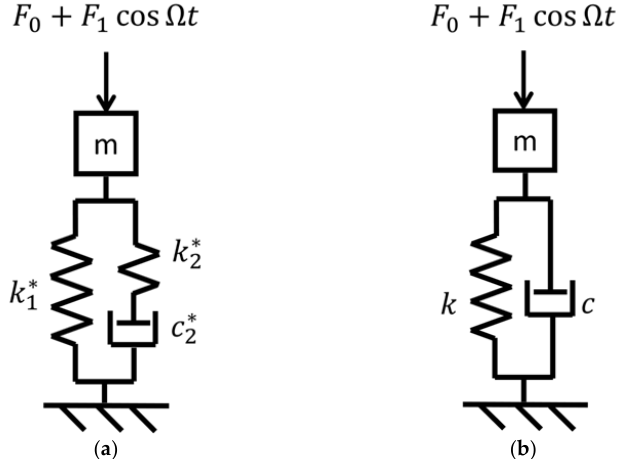
Figure 9. Mechanical model of unit length of the reference ERS subjected to external force for time domain simulation: ( a ) non-linear Zener model with preload-dependent parameters; ( b ). linear Kelvin-Voigt model.